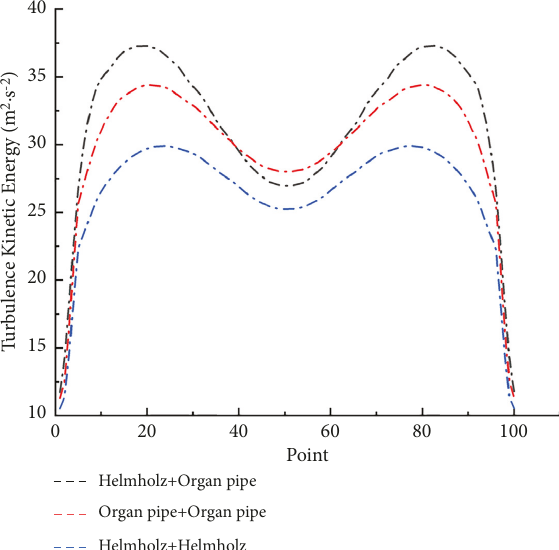
Figure 13: Turbulent kinetic energy distribution of different dual-chamber self-excited oscillating pulsed nozzles.